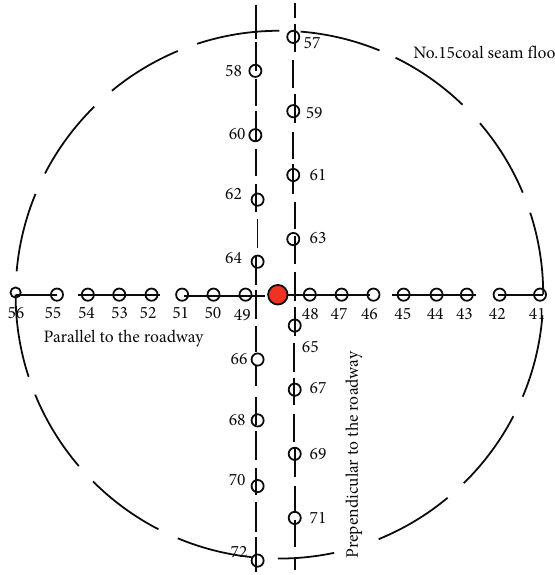
Figure 8: Schematic diagram of blast observation hole